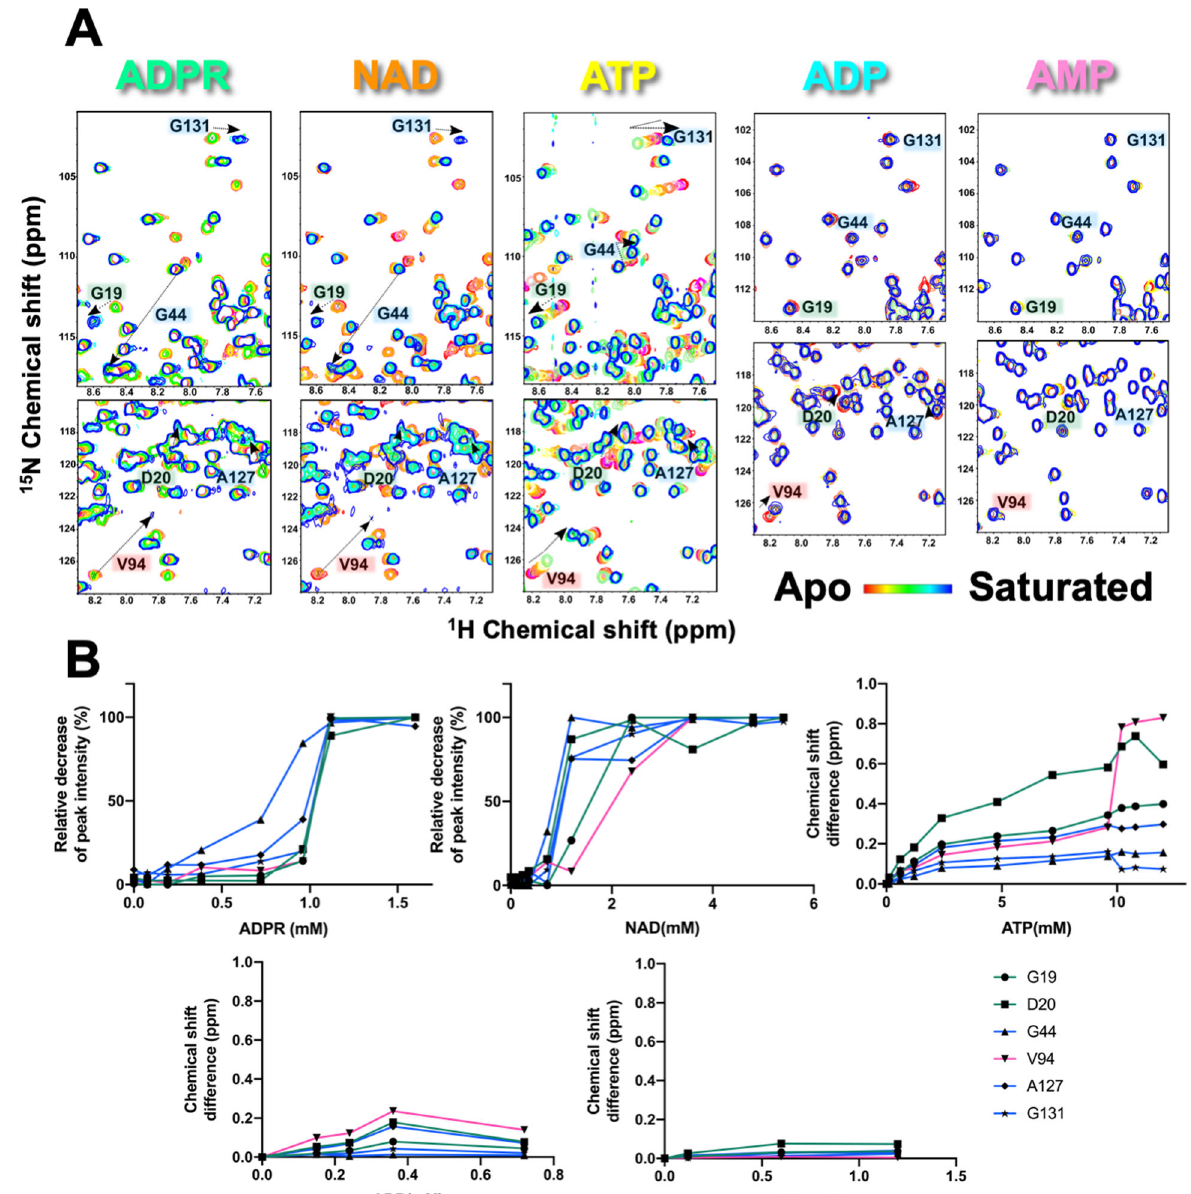
Fig. 5 Chemical shift perturbations of residues in three regions of ligand binding site at 308 K. A Overlays of the 1 H- 15 N HSQC spectra of residues in three regions of the ligand-binding site of the MERS-CoV macro domain alone and a series of NAD metabolites titrations. B The decrease in intensity of cross-peaks and the chemical shift difference of residues selected are plotted against the concentration of titrated NAD